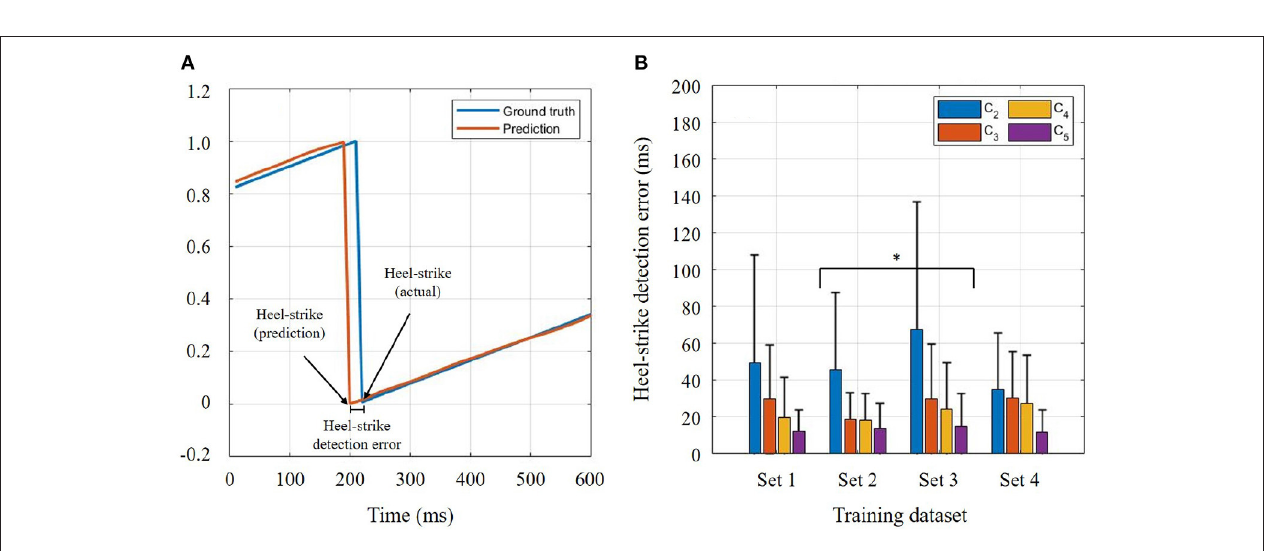
FIGURE 6 | Heel-strike detection error. (A) Temporal difference between actual heel-strike and predicted heel-strike. (B) Heel-strike detection error in four different speed conditions. The general model was chosen for the comparison. Bar graphs and error bars correspond to the mean and + 1SD. Bar colors correspond to walking speeds: C 2 , C 3 , C 4 , and C 5